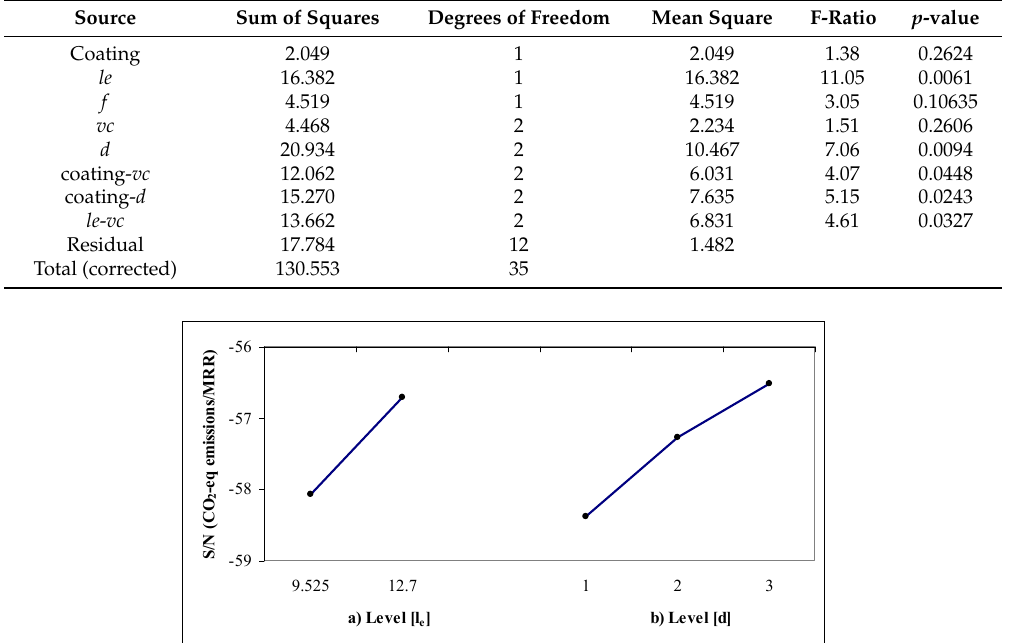
Figure 4. Values of the S/N ratios of the significant main factors for CO 2 -eq emissions/MRR.